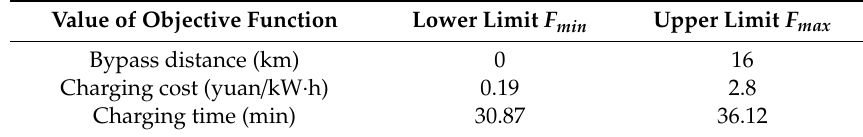
Table 7. The upper and lower limits of the three objective function values acceptable to the user.